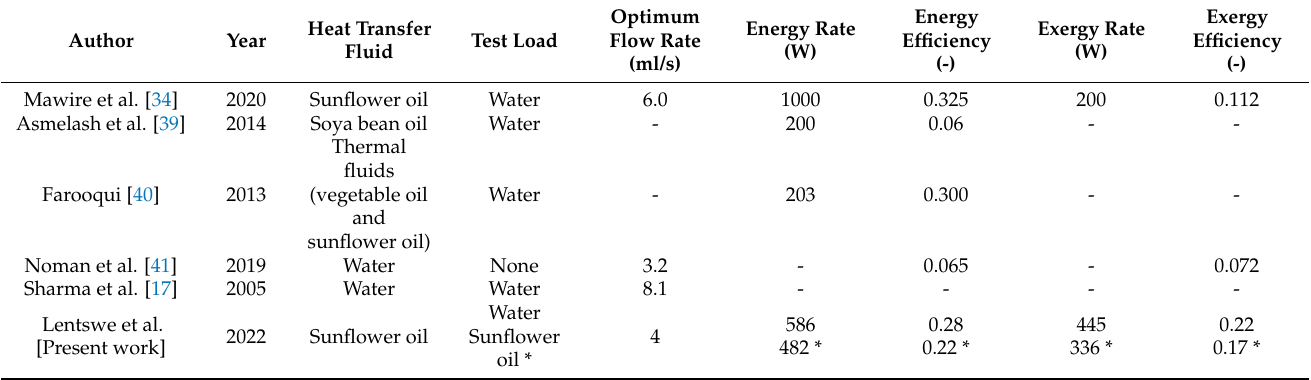
Table 5. A comparison of the present work with previous work completed by other